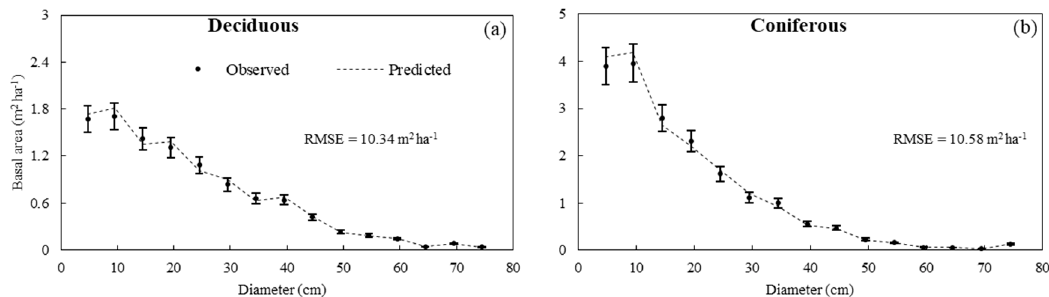
Figure 4. Predicted and observed basal area and RMSE for deciduous species group ( a ) and coniferous species group ( b ) using the matrix models with diameter classes of the 95% confidence interval of the observed mean values in the Northern US.